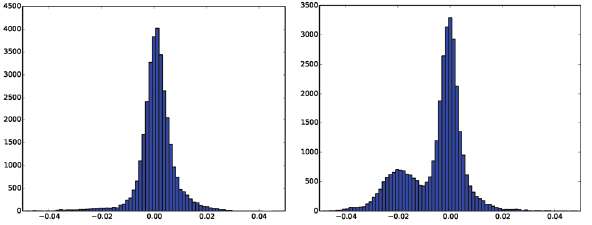
Figure 14. Histogram of deviations between -5 cm and +5 cm after adjustment for scanner 1 (left) and 2 (right), for 28